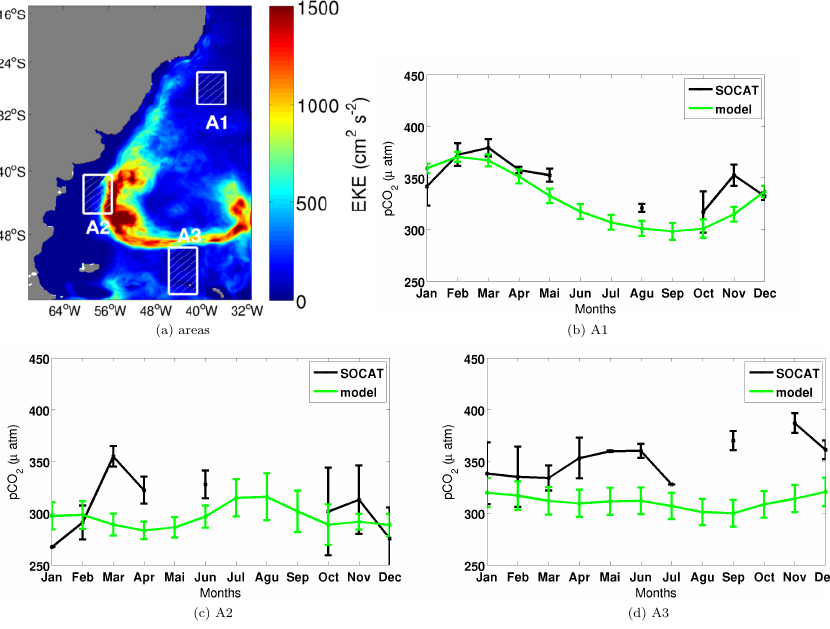
Figure 4. Location of the three areas used for the monthly comparison with SOCAT database (a) in a map with annual mean eddy kinetic energy. In panels (b) , (c) and (d) , green lines are the modeled monthly mean p CO 2 and black lines are the monthly mean p CO 2 from SOCAT. Error bars are two standard